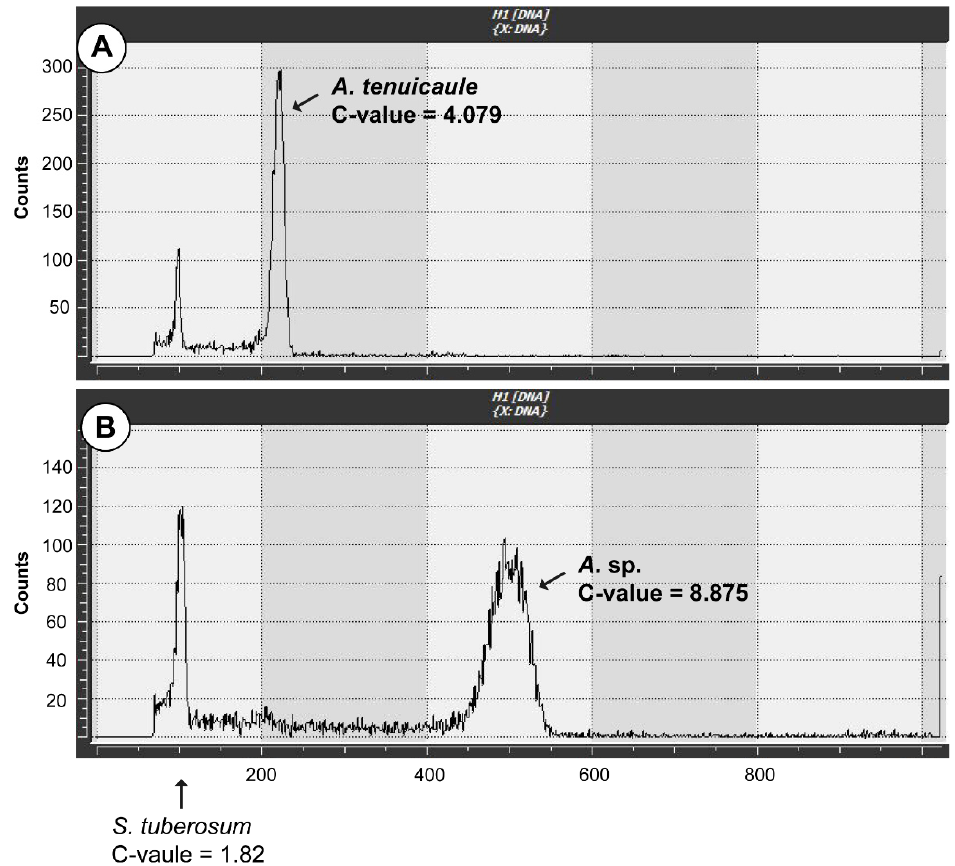
Figure 3. Results of genome size measurement using a flow cytometer. ( A ) Asplenium tenuicaule , ( B ) Asplenium sp.